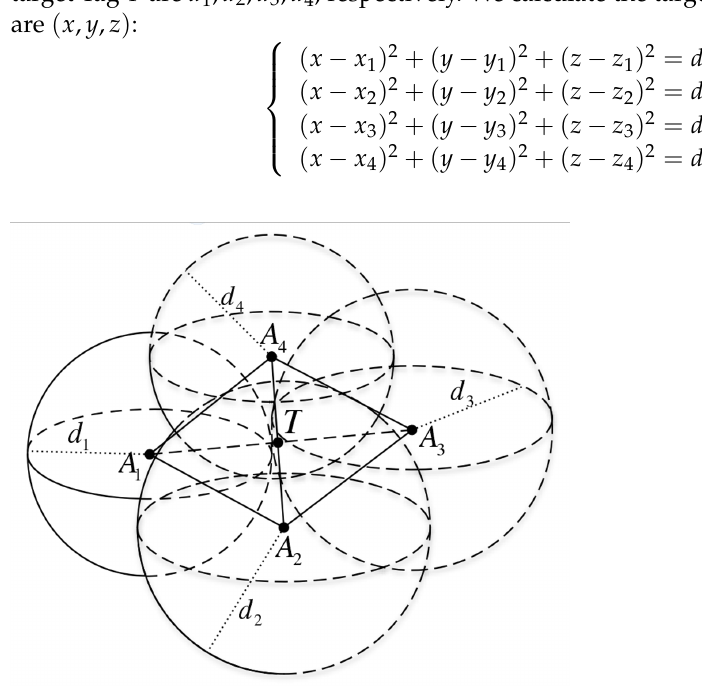
Figure 5. Traditional quadrilateral location